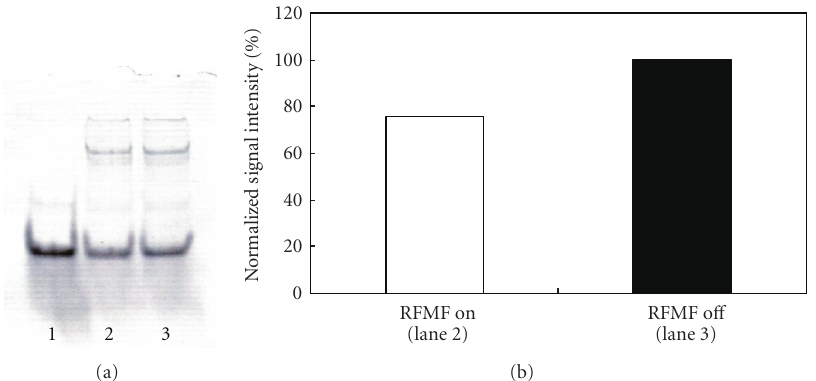
Figure 5: The confirmation of hybridization between FcDNA and Au-TBA by native PAGE. (a) Lane 1 shows a fluorescence image of 20- mer FcDNA. Lane 2 shows a fluorescence image of FcDNA with thrombin and Au-TBA after RFMF irradiation. Lane 3 shows a fluorescence image of FcDNA with thrombin and Au-TBA after incubation for 5min at room temperature. (b) Signal intensity of FcDNA of Lane 2 and 3 normalized to Lane